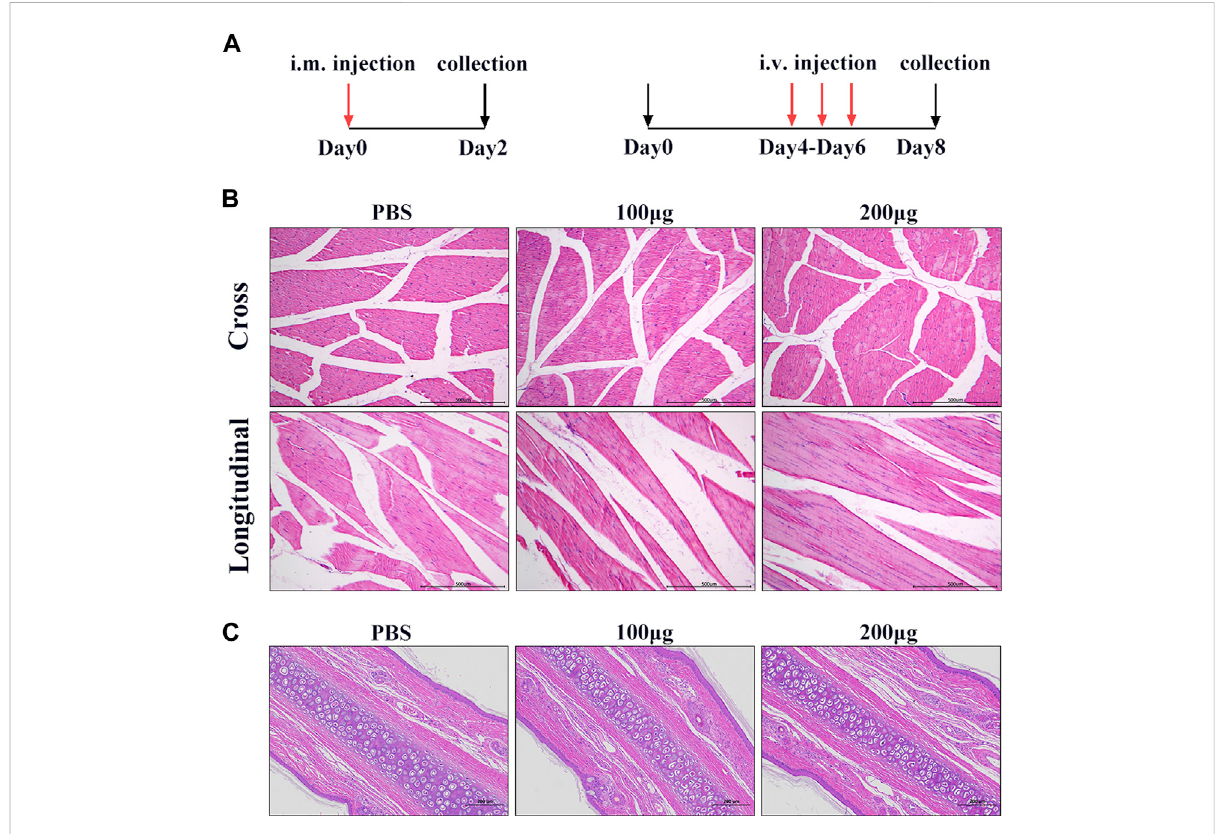
Muscle and vascular stimulation by hiPSC-exosomes. (A) Experimental design for injection of hiPSC-exosomes into muscle and vascular stimulation. (B) HE staining of muscle in cross-sections and longitudinal sections from control and experimental groups. N = 4 per group. (C) HE- stained sections of marginal ear veins in control and experimental groups. N = 4 per